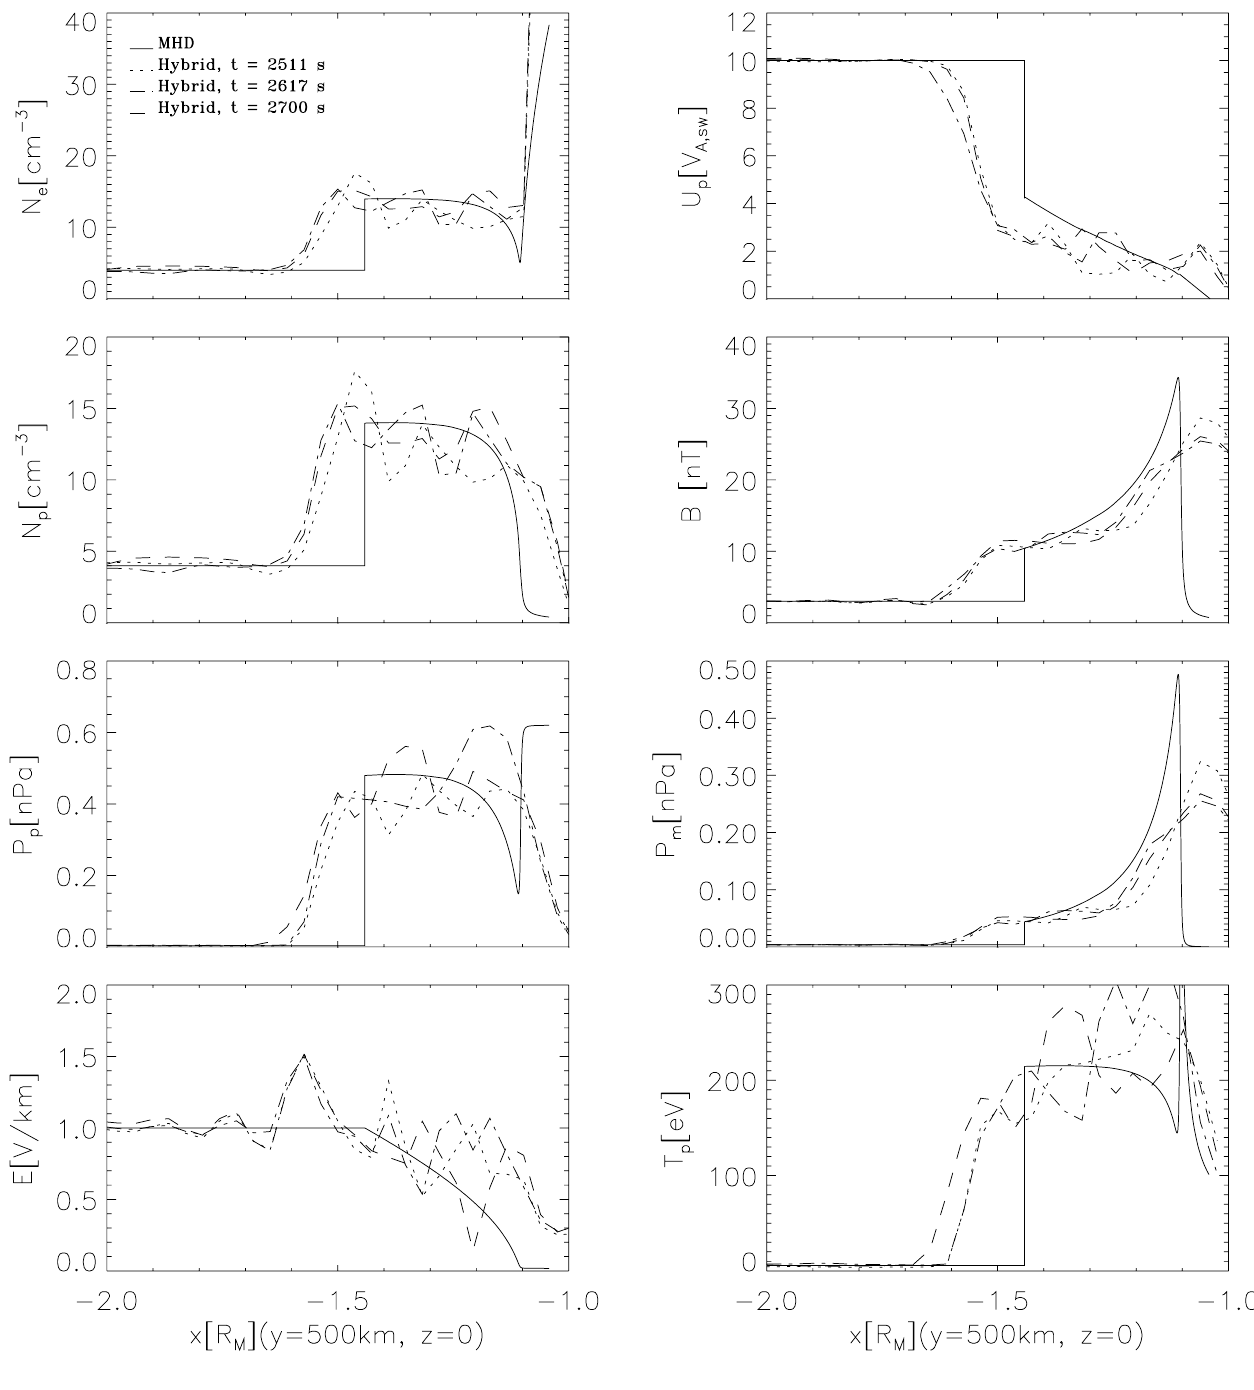
Fig. 3a. Comparison of MHD and hybrid magnetosheath profiles along the x-direction for y =500km, z =0.